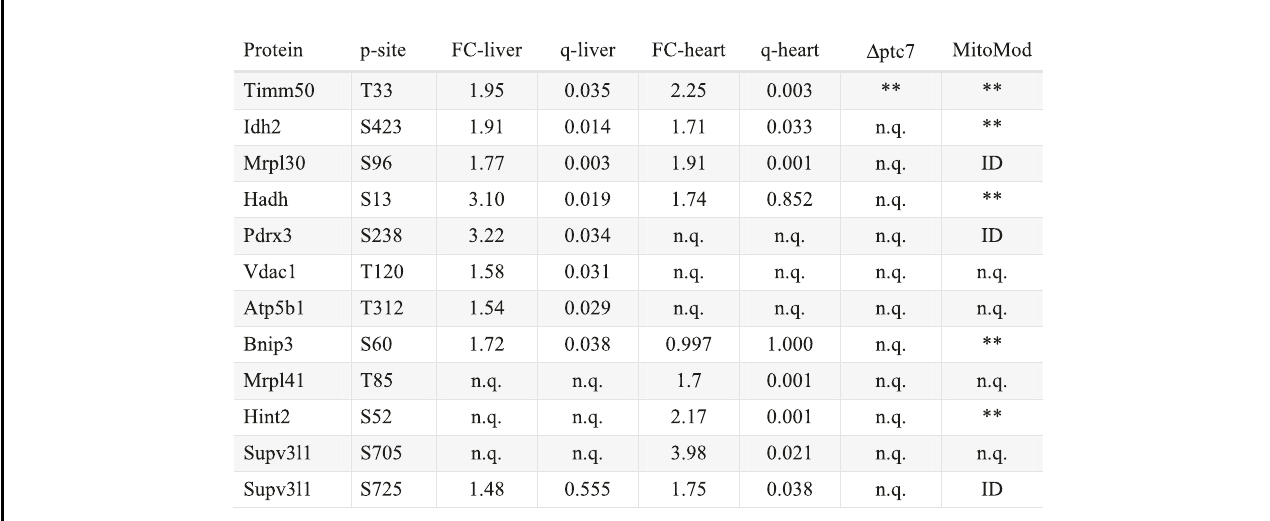
Groupsofphosphoisoformsshownbyproteinnameandphosphositeidenti fi ed(labeledp-siteintable),withrelativefoldchanges(FC)and q -values(calculatedbyBenjamini – Hochbergmultiplehypothesis correction, labeled q in table) in heart and liver Pptc7 KO tissues. Identi fi cation of phosphoproteins in Δ ptc7 yeast 17 and in our previous study of obese mice (MitoMod) 6 also reported; ** = signi fi cantly changing as calculated by a two-tailed Student ’ s t -test for the Δ ptc7 dataset or by multiple hypothesis testing via FDR calculation as detailed in ref. 6 . ID = identi fi ed; n.q. = not quanti fi ed. Timm50 (top) was signi fi cantly altered in both tissues and both previous studies, warranting biological follow